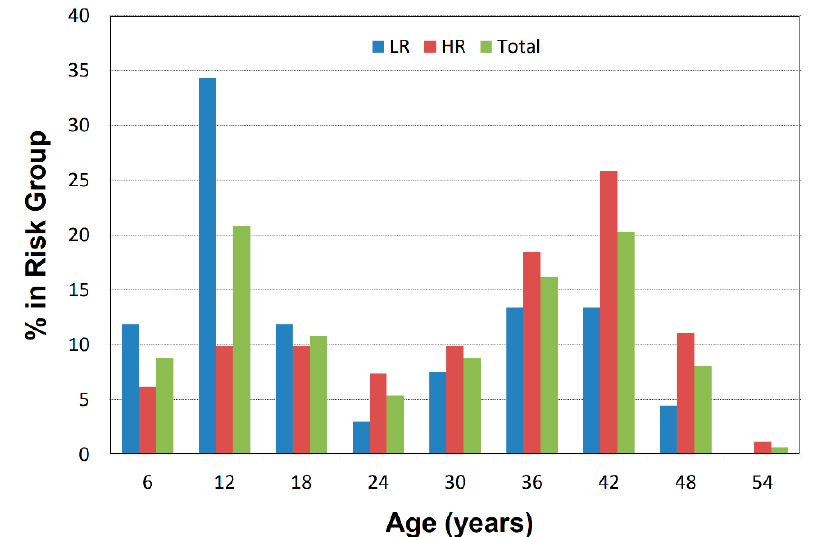
Figure 1. Age Distributions for High- and Low-Risk Groups . The percentage of participants in each risk group who are found in each age bin is plotted against age in 6-year bins. Plots are shown separately for the low-risk group, high-risk group, and the total sample. The 7–12-year age bin has more low-risk than high-risk children.